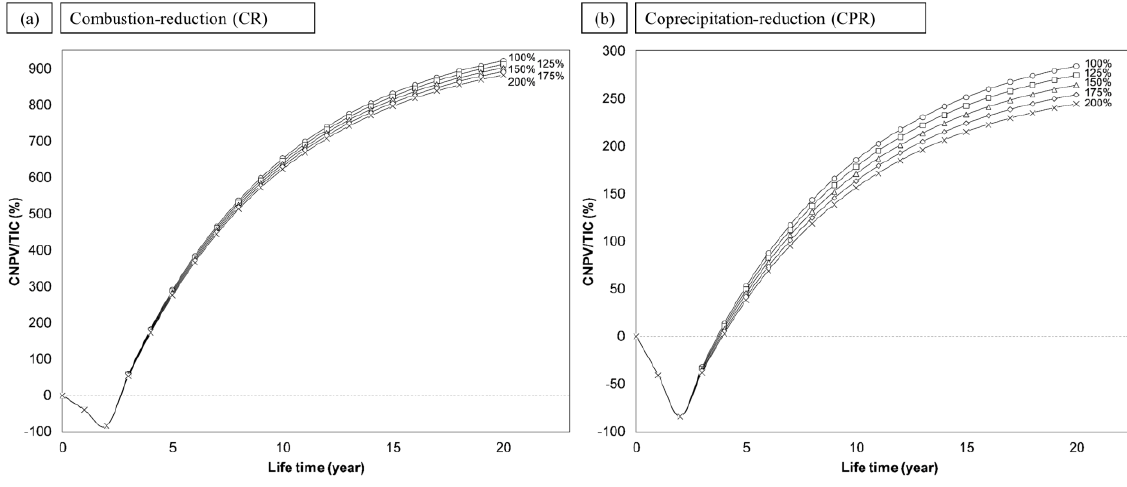
Fig. 11. CNPV/TIC curves in accordance to life time for (a) combustion-reduction (CR) and (b) co-precipitation-reduction (CPR) under various employee